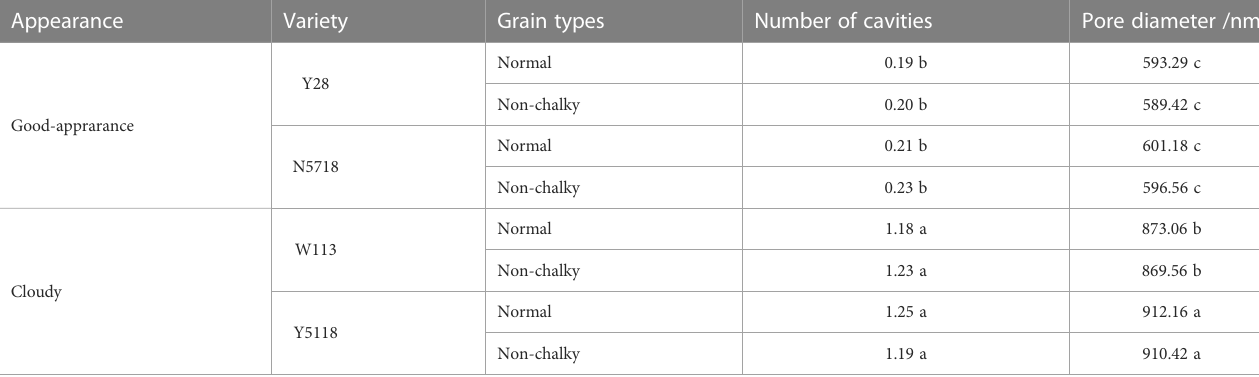
TABLE 2 Comparison of cross-sectional cavities of individual starch grains at maturity. Appearance